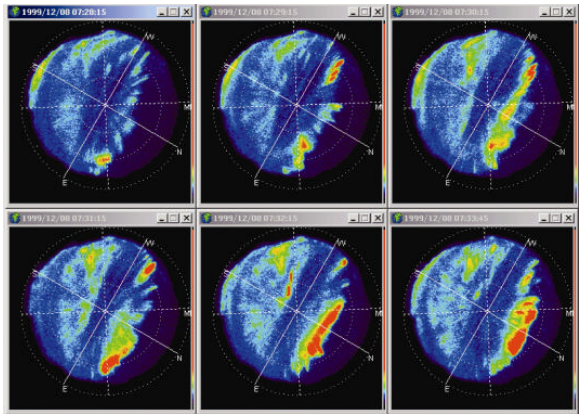
Figure 5 Fig. 5. ASC images at 557.7nm from Ny ˚Alesund, representing the times 07:28:15, 07:29:15, 07:30:15, 07:31:15, 07:32:15, and 07:33:45 UT. Same format as in Fig. 3.